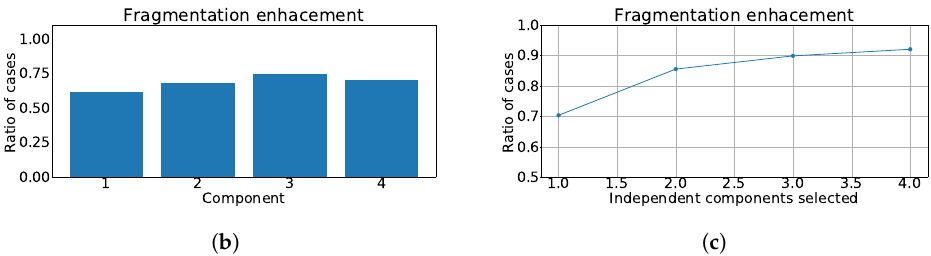
Figure 13. Different measurements for the lateral region of the heart with ICA model. ( a ) Distribution of ρ RMSE coefficient for each independent component, values lower than zero represents cases where the RMSE measured over the ECG is greater than RMSE measured over the independent component. ( b ) Ratio of fragmentation wave enhancement for each independent component, this ratio is computed as cases where the ρ RMSE value is greater than zero. ( c ) Cumulative ratio of fragmentation wave enhancement, this ratio is computed by joining the results of isolated independent components.